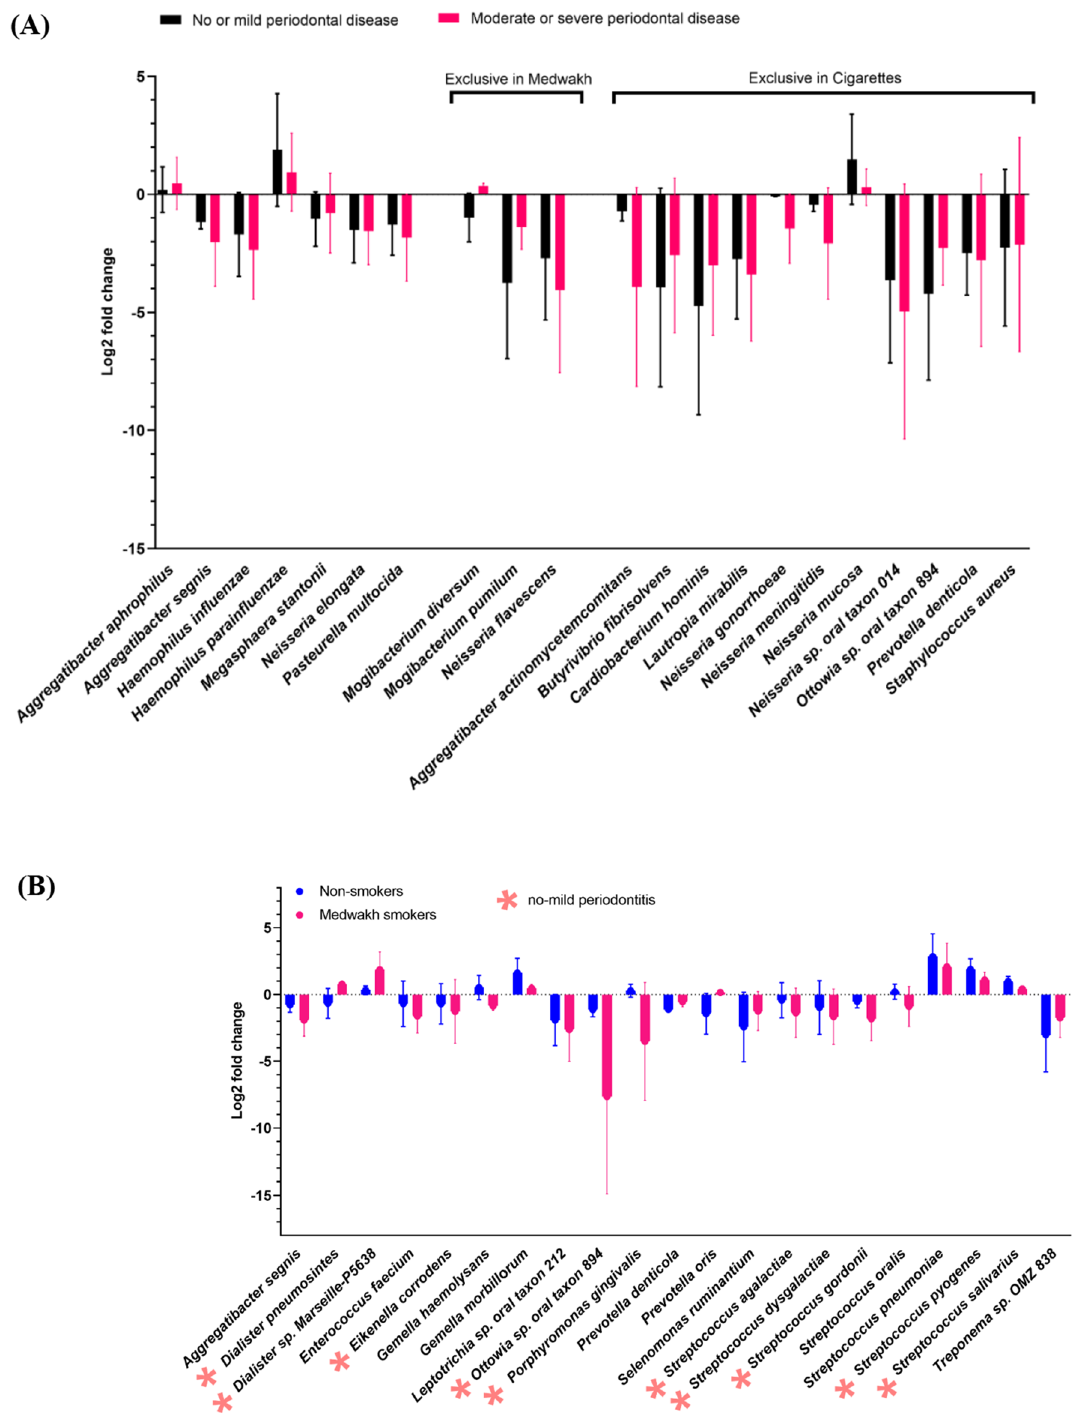
Figure 5. Comparison of the relative abundance (log 2 transformed ± SD) of species by ( A ) periodontal disease severity and ( B – G ) smoking status. Only significantly different species are shown. Species exclusively differentially abundant in patients with no or mild periodontal disease and patients with moderate or severe periodontal disease are marked with pink and blue asterisks, respectively ( B – G